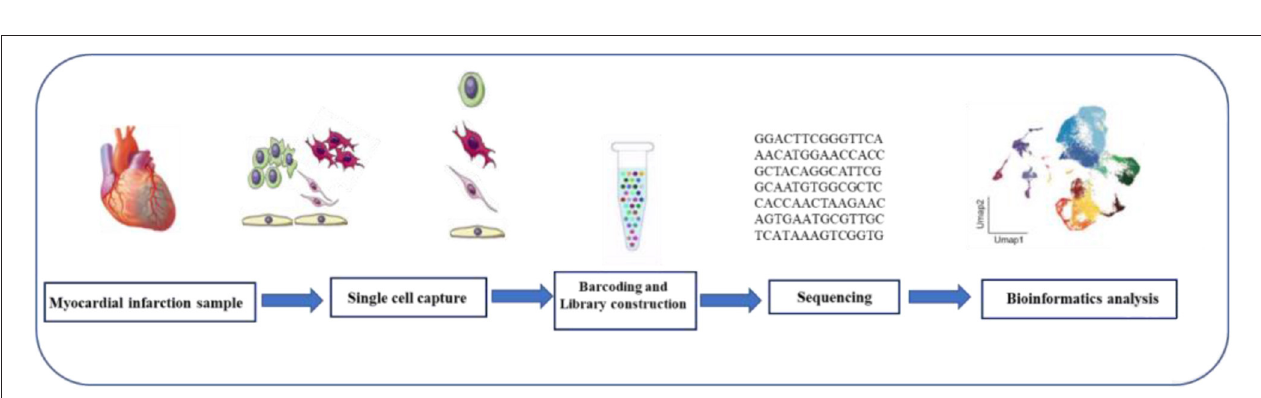
FIGURE 2 | Single-cell RNA sequencing workflow. The scRNA-seq process includes tissue digestion, isolation of single cell or single nucleus, reverse transcription, cDNA amplification, construction of sequencing libraries, sequencing, and data analysis.